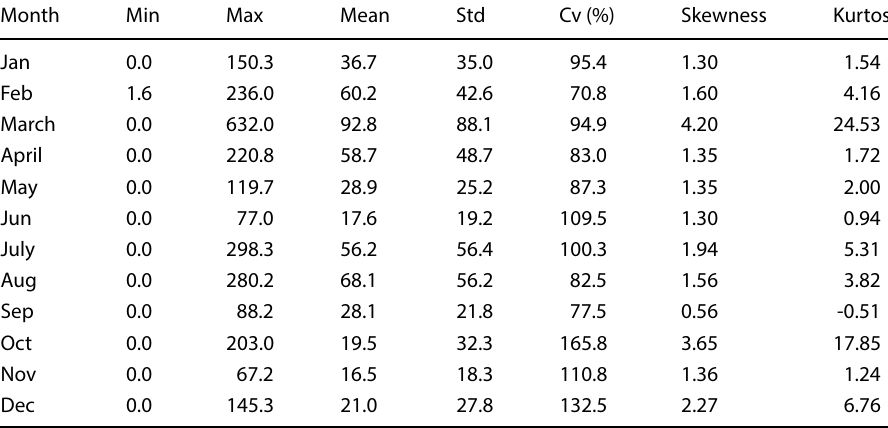
Table 1 Statistical information of rainfall data for Peshawar station from 1960 to 2020 Source :